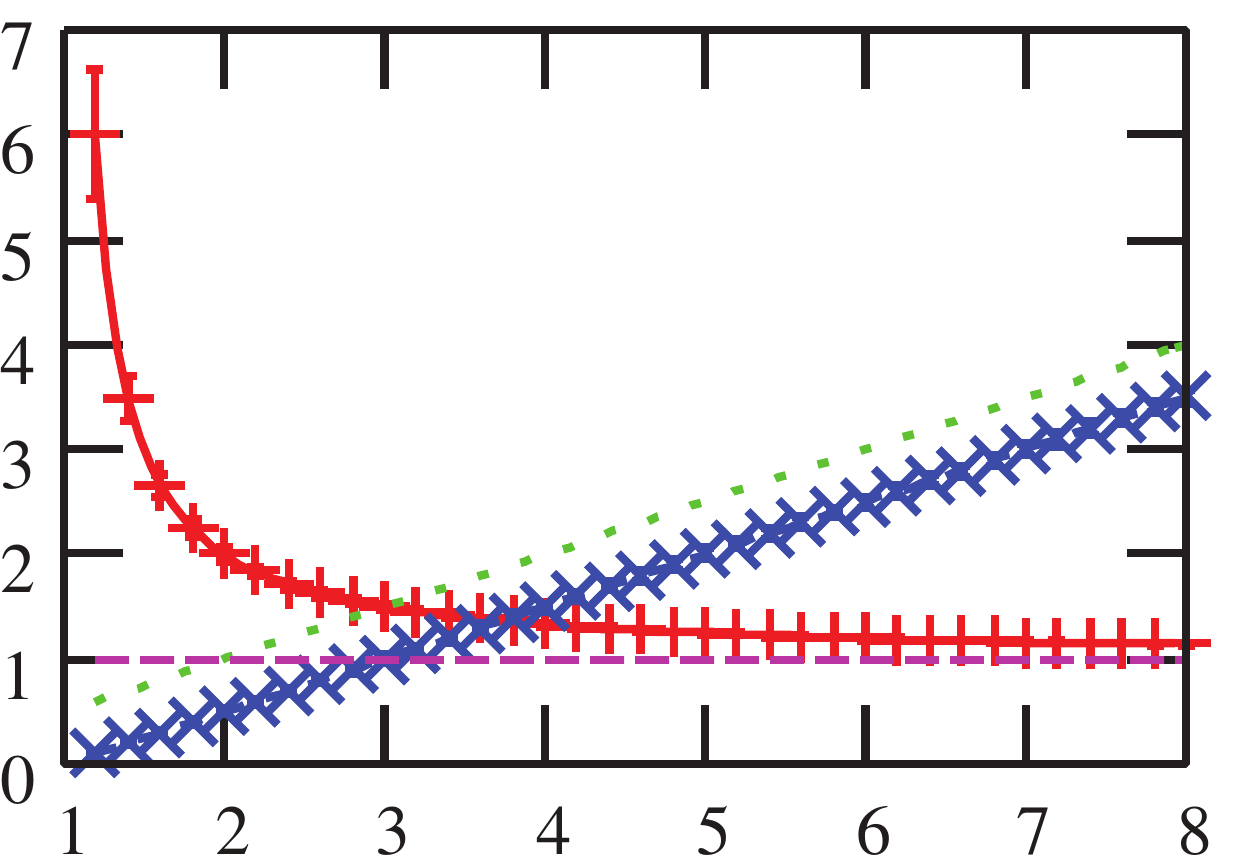
Fig 1. The investment risk ε and the concentrated investment level q w are shown for the case in which the return rate x k μ is independently and identically distributed with a standard normal distribution. The horizontal axis indicates the scenario ratio α = p / N , and the vertical axis shows the investment risk and the concentrated investment level q w . The two solid lines (results obtained by our proposed approach) and the two dotted lines (results obtained by the operations research approach) are theoretical results. The markers with error bars are the numerical results evaluated using the optimal solution according to a return rate which was randomly assigned. In the simulation, the number of investment outlets N was 10 3 , and we averaged 100 return n . This fi gure shows that the results obtained by our proposed approach (solid lines) and the numerical results (markers with error bars) are in agreement. On the other hand, the results obtained by the operations research approach (dotted lines) do not coincide with the others. Thus, unfortunately, the approach based on maximizing the expected utility cannot propose an optimal investment